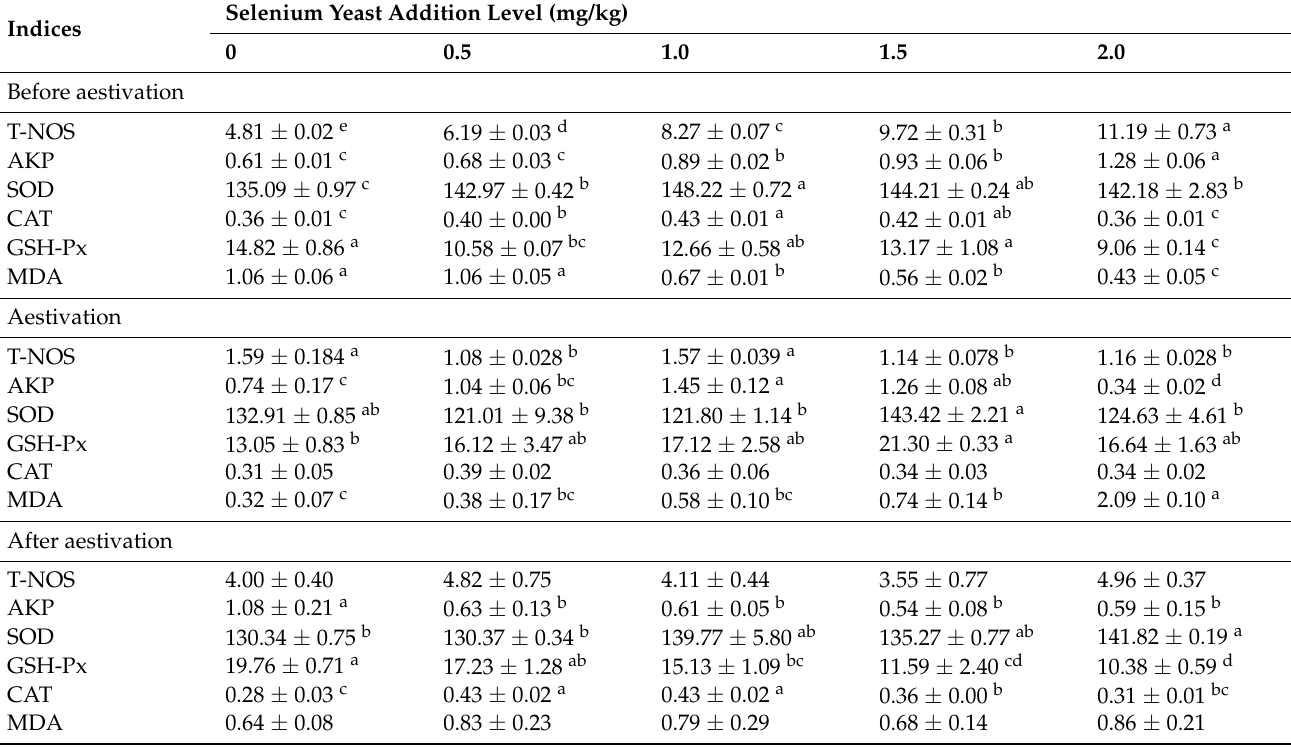
Table 5. Effects of selenium yeast supplementation on the immunity enzyme activities and antioxidant capacity of juvenile sea cucumber ( Apostichopus japonicus ) before and after aestivation (means ± SE, n =